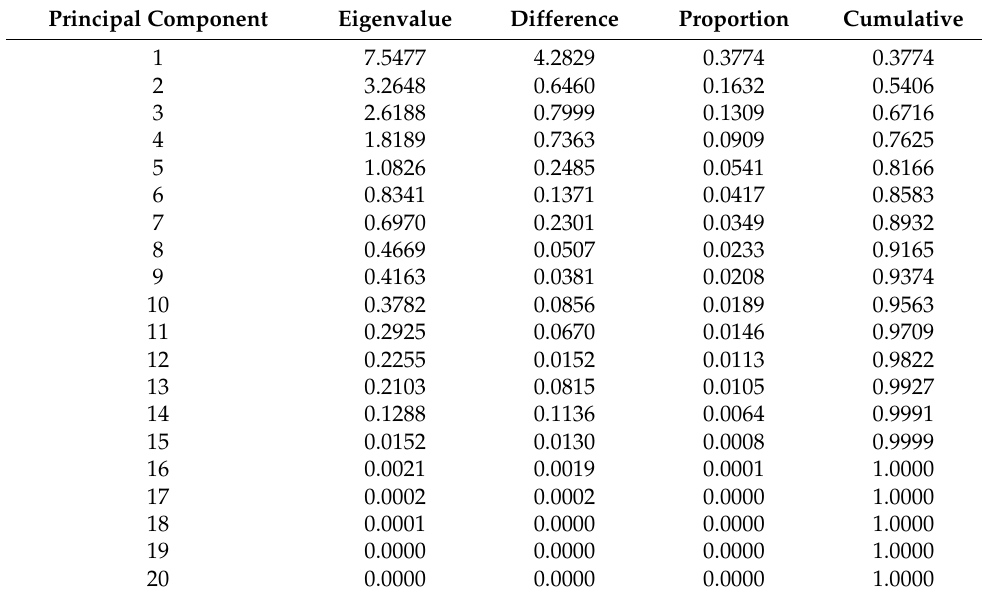
Table 3. Eigenvalues and proportions of principal components to 20 quantitative traits of 468